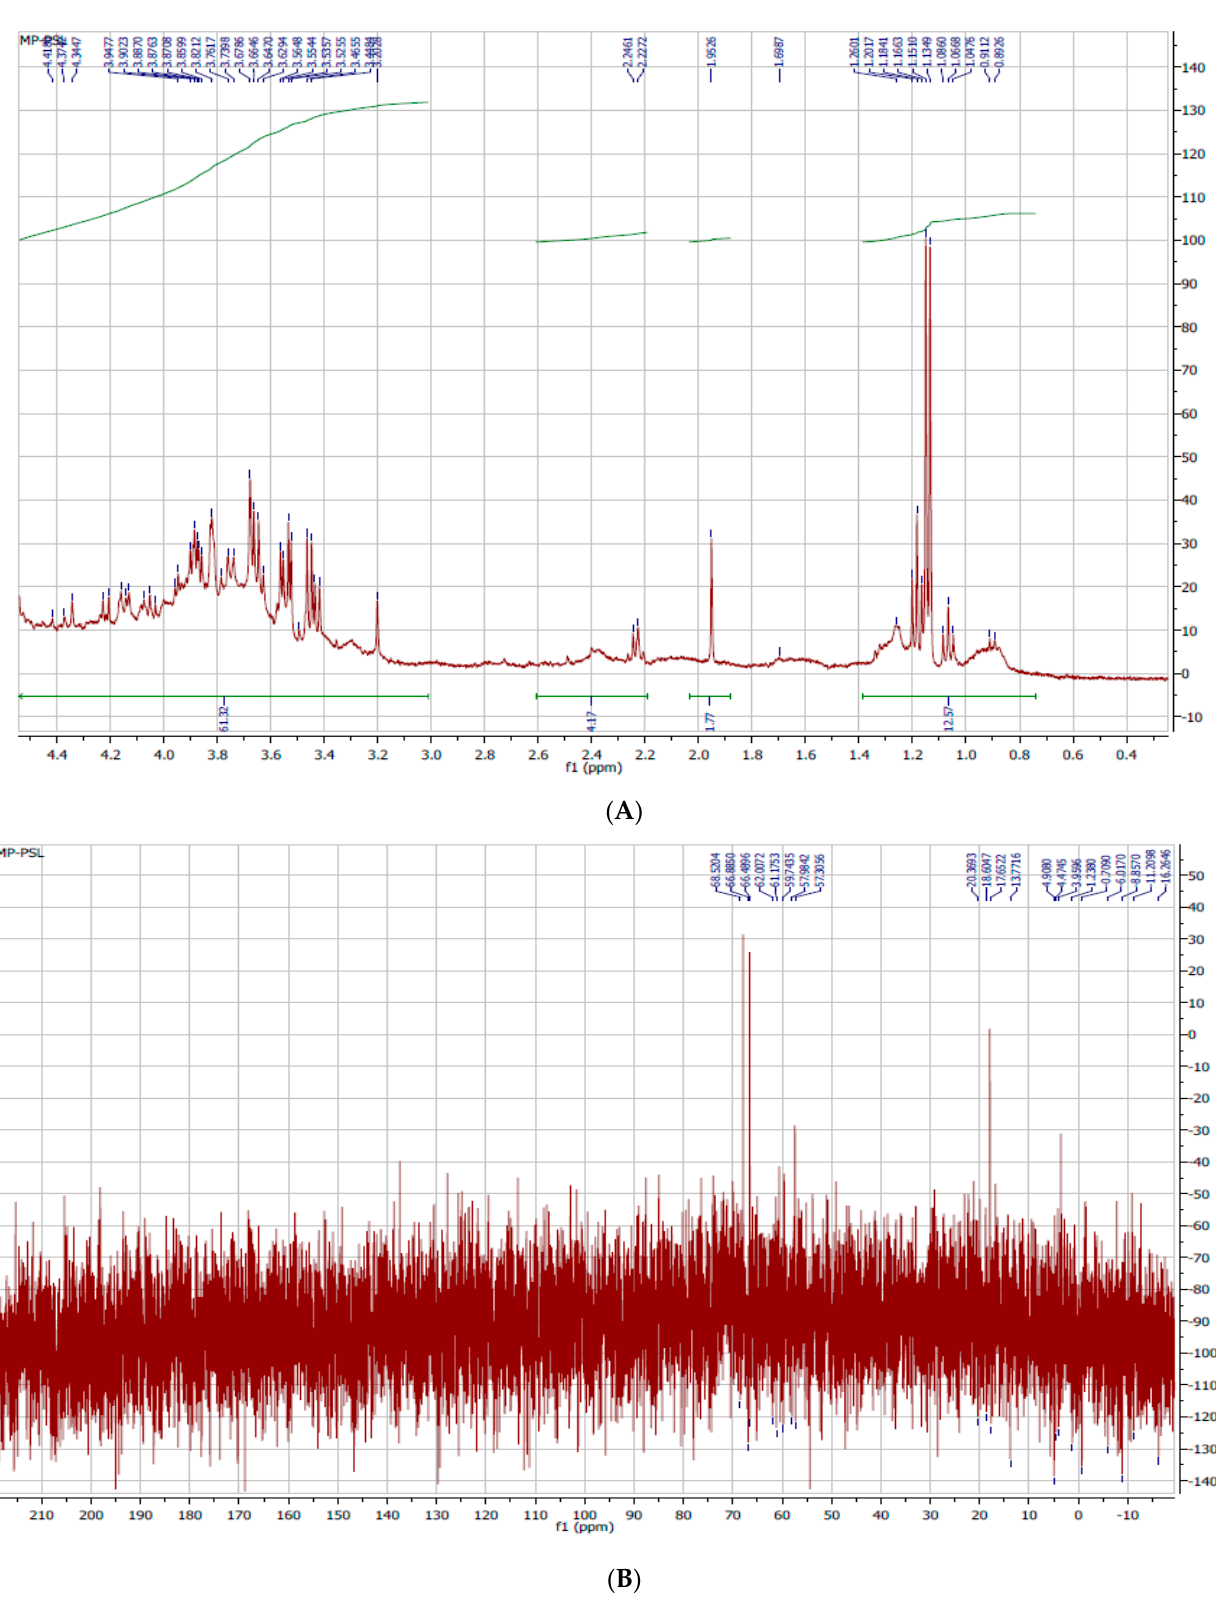
Figure 2. ( A ) 1 H NMR spectrum of LWSP in D 2 O at 400 MHz and 25 °C, ( B ): solid state 13 CP/MAS NMR spectrum of LWSP at 75.5 MHz and 25 °C.